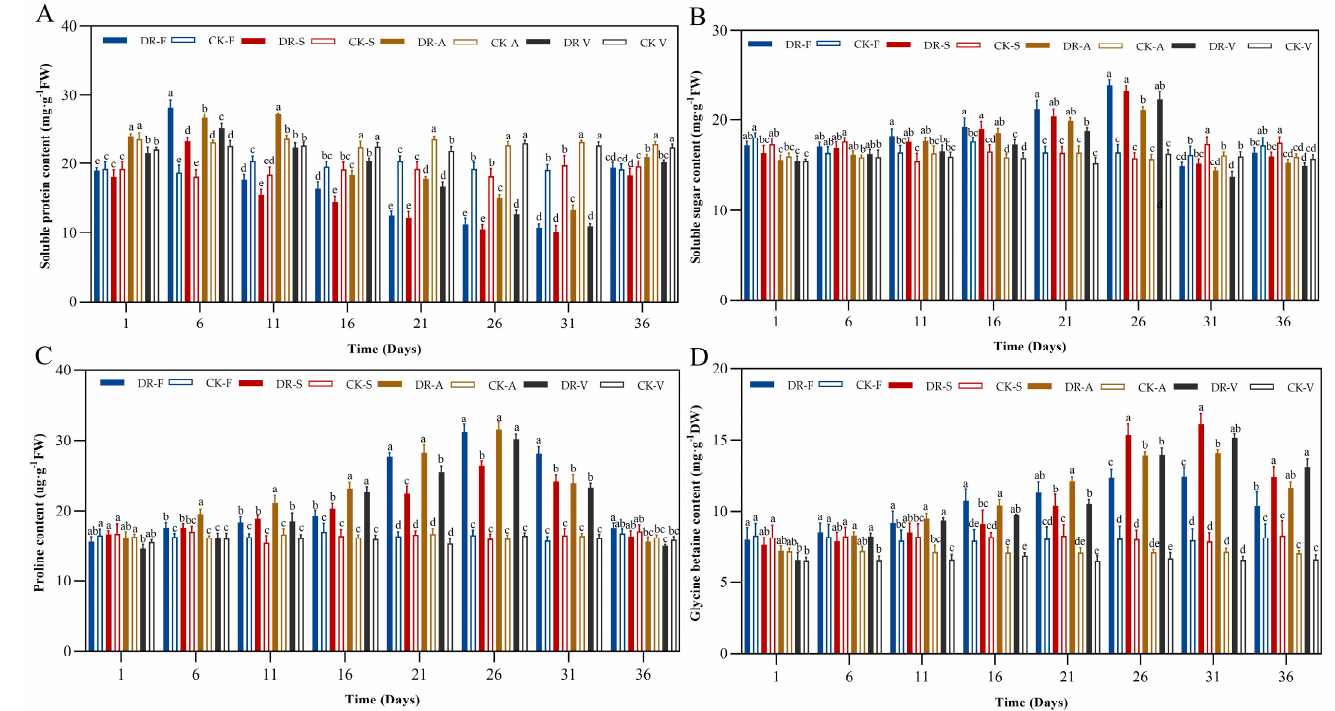
Figure 3. Effects of drought stress and rewatering on osmotic solutes content of four oak species ( A ) soluble protein, ( B ) soluble sugar, ( C ) proline, ( D ) glycline betaine. DR-F: drought-rewatering sample of Q. fabri ; CK-F: well watered sample of Q. fabri ; DR-S: drought-rewatering sample of Q. serrata ; CK-S: well watered sample of Q. serrata ; DR-A: drought-rewatering sample of Q. acutissima ; CK-A: well watered sample of Q. acutissima ; DR-V: drought-rewatering sample of Q. variabilis ; CK-V: well watered sample of Q. variabilis . Different lowercase letters indicate significant ( p < 0.05) differences